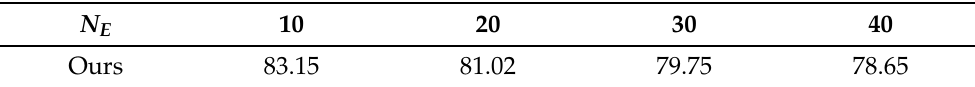
Table 4. Recognition accuracy (%) of the aerial scene classification using different numbers of training epochs N E for early training of three models.